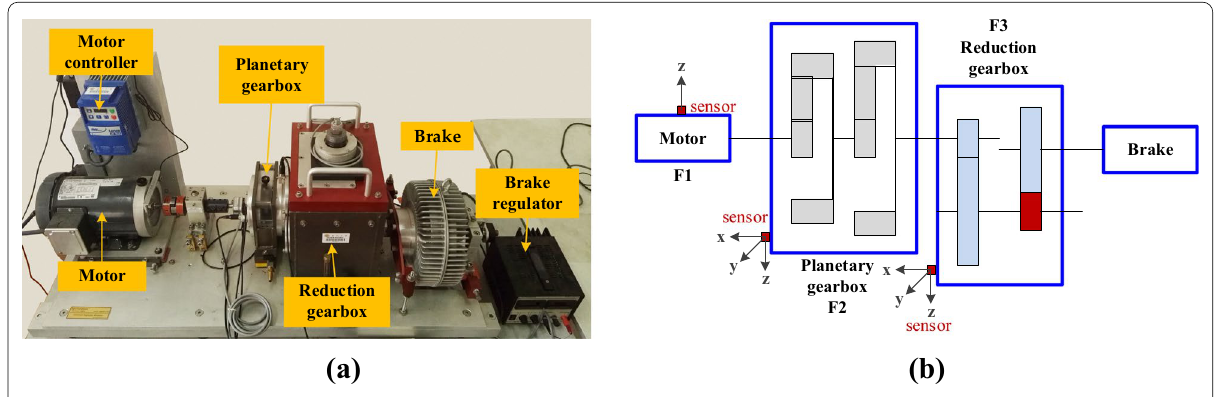
Figure 4 Spectra quest’s drivetrain dynamics simulator: (a) The real chart of system; (b) The structure chart of system